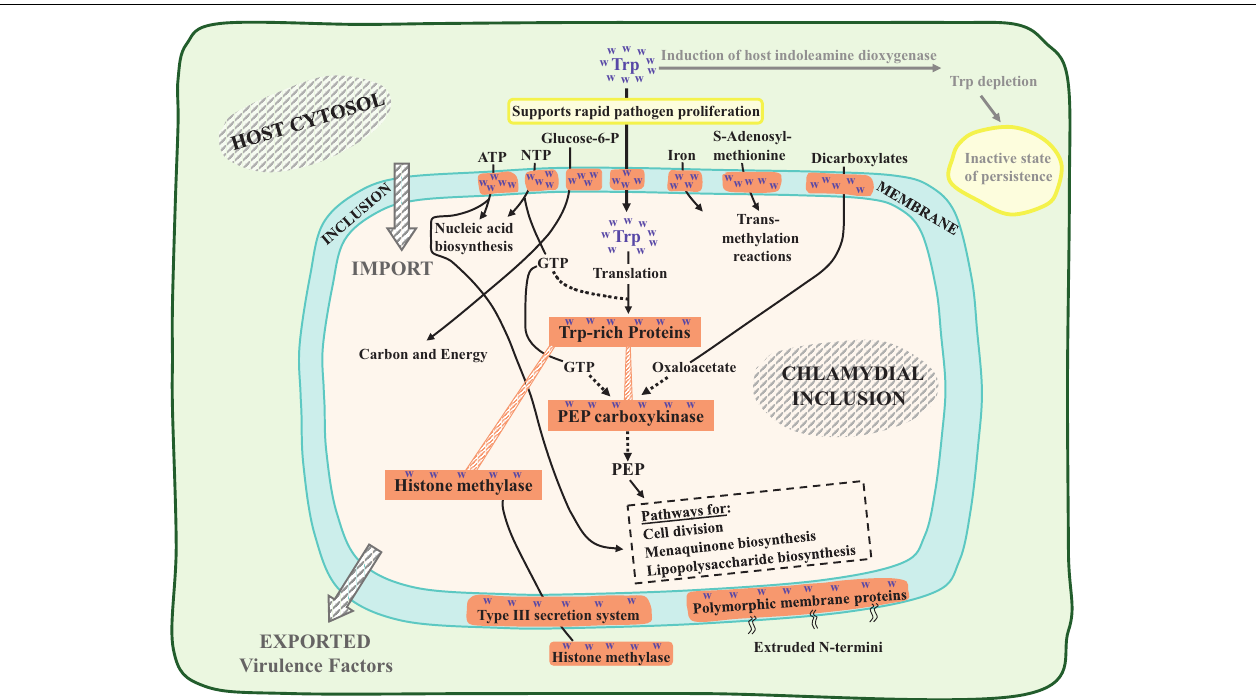
FIGURE 2 | Key elements in the C. trachomatis pathogen of a response network which is tuned to adequate Trp availability from human host cytosol. Two alternative flow routes for cytosolic Trp are indicated. The rightward flow route (dimmed) is initiated with the induction of indoleamine dioxygenase (IDO). When Trp is fully available prior to the triggering of any process accomplishing Trp depletion (downward bold arrow), a schedule of rapid pathogen proliferation is supported by expression of key Trp-rich proteins. Many of these are